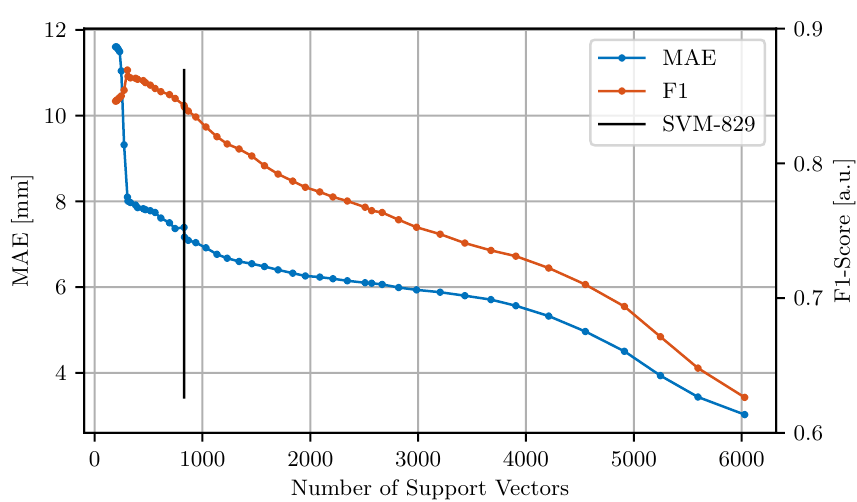
Figure 6. Computational complexity measured by number of support vectors and its influence on regression and binary classification